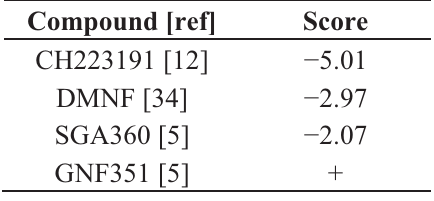
Table 3. Docking analysis of antagonists and selective